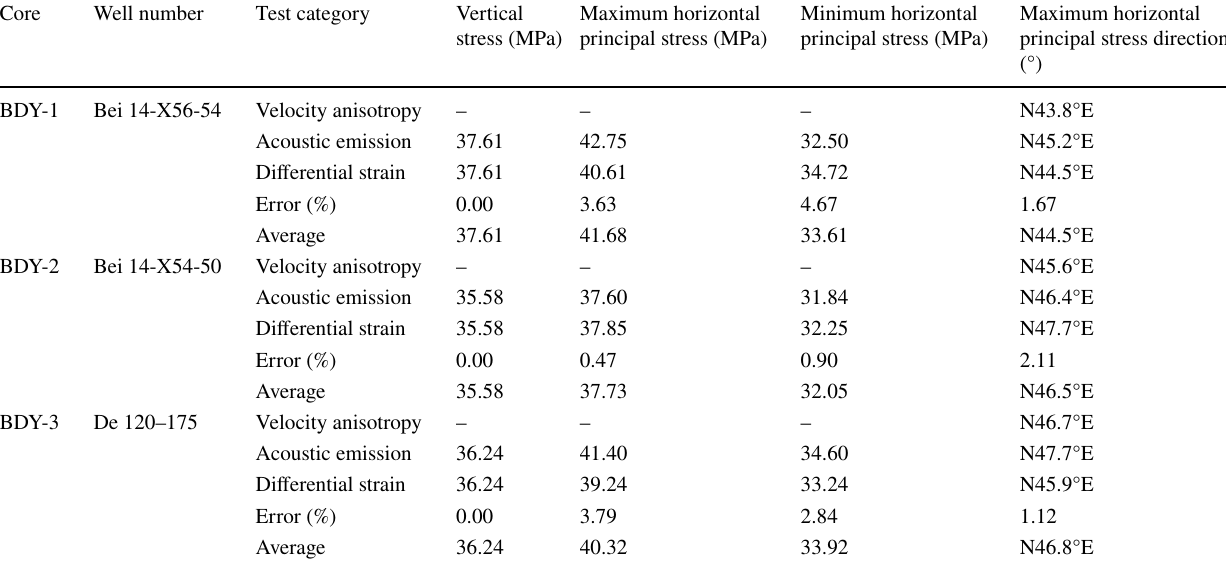
Table 3 Ground stress test results in block 14 of Hailarbei